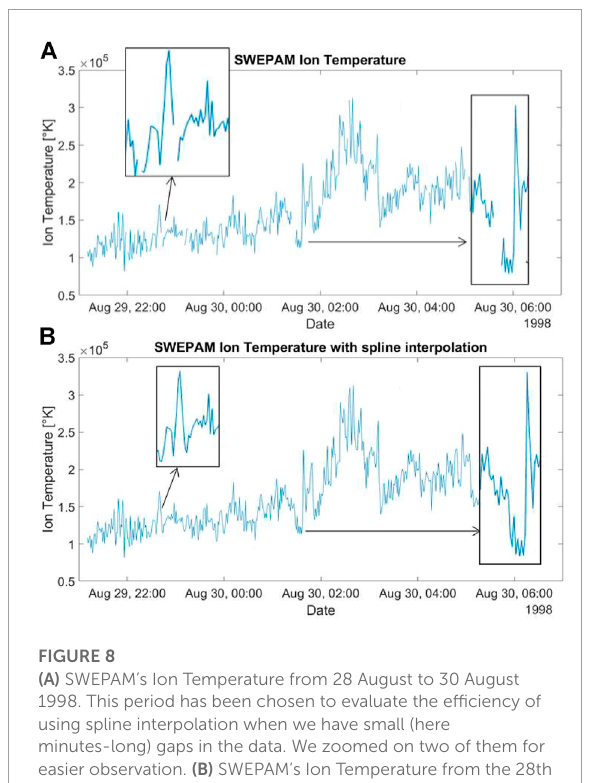
FIGURE 8 (A) SWEPAM’s Ion Temperature from 28 August to 30 August 1998. This period has been chosen to evaluate the efficiency of using spline interpolation when we have small (here minutes-long) gaps in the data. We zoomed on two of them for easier observation. (B) SWEPAM’s Ion Temperature from the 28th of August to the 30th of August 1998. Gaps seen in Figure 8A are now filled using a spline interpolation. We zoomed on the same two periods for easier observation.